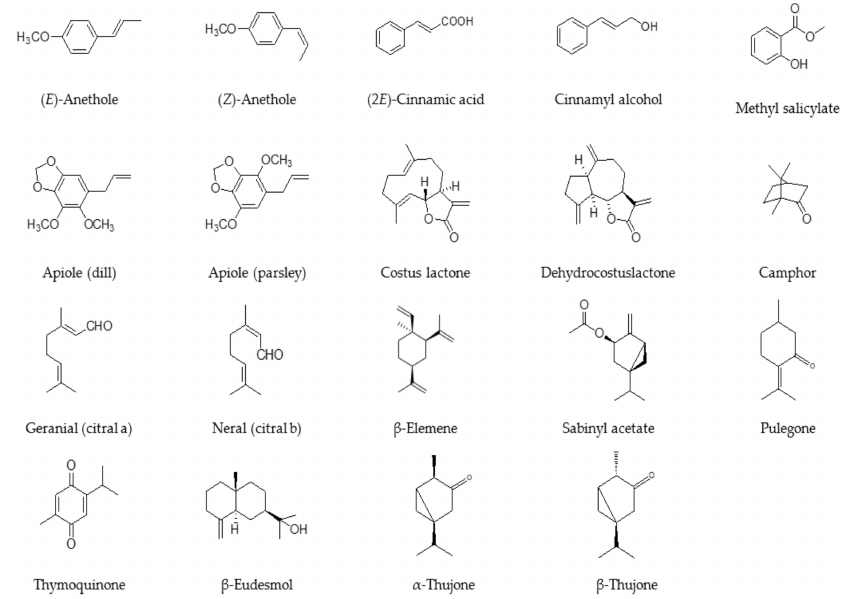
Figure 1. Chemical structures of key essential oil components discussed in this